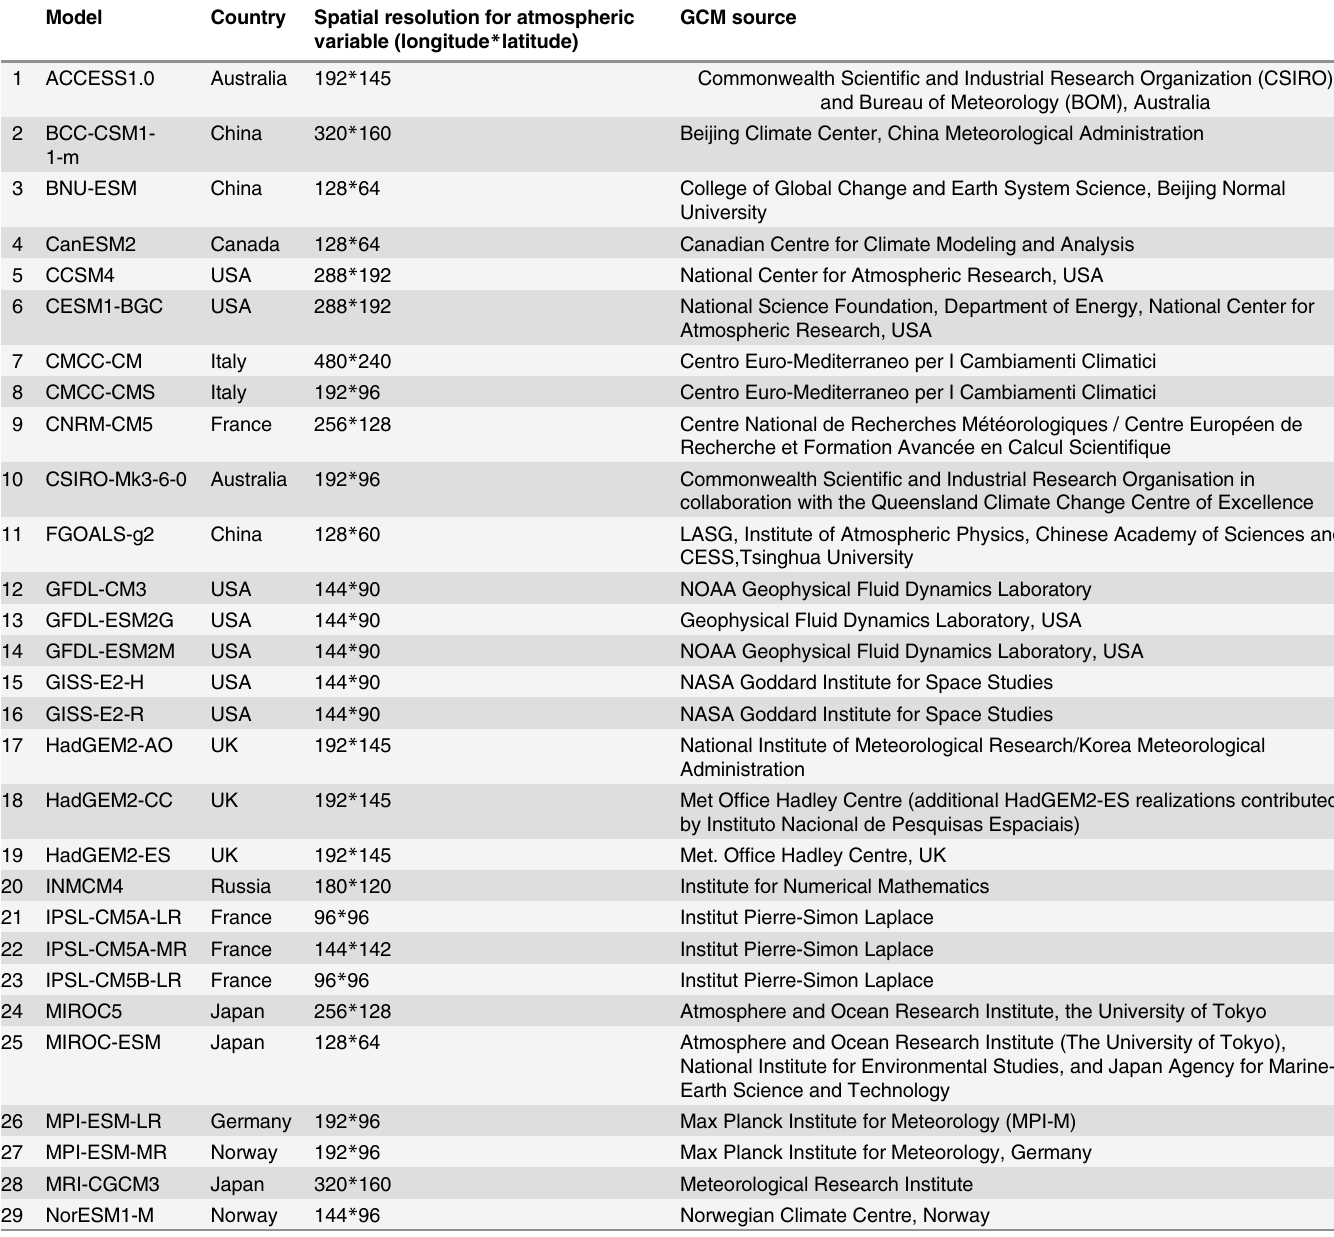
Table 2. List of the CMIP5 GCMs used in this study as future projection climate data in SALUS model. Model Country Spatial resolution for atmospheric GCM variable (longitude * latitude)